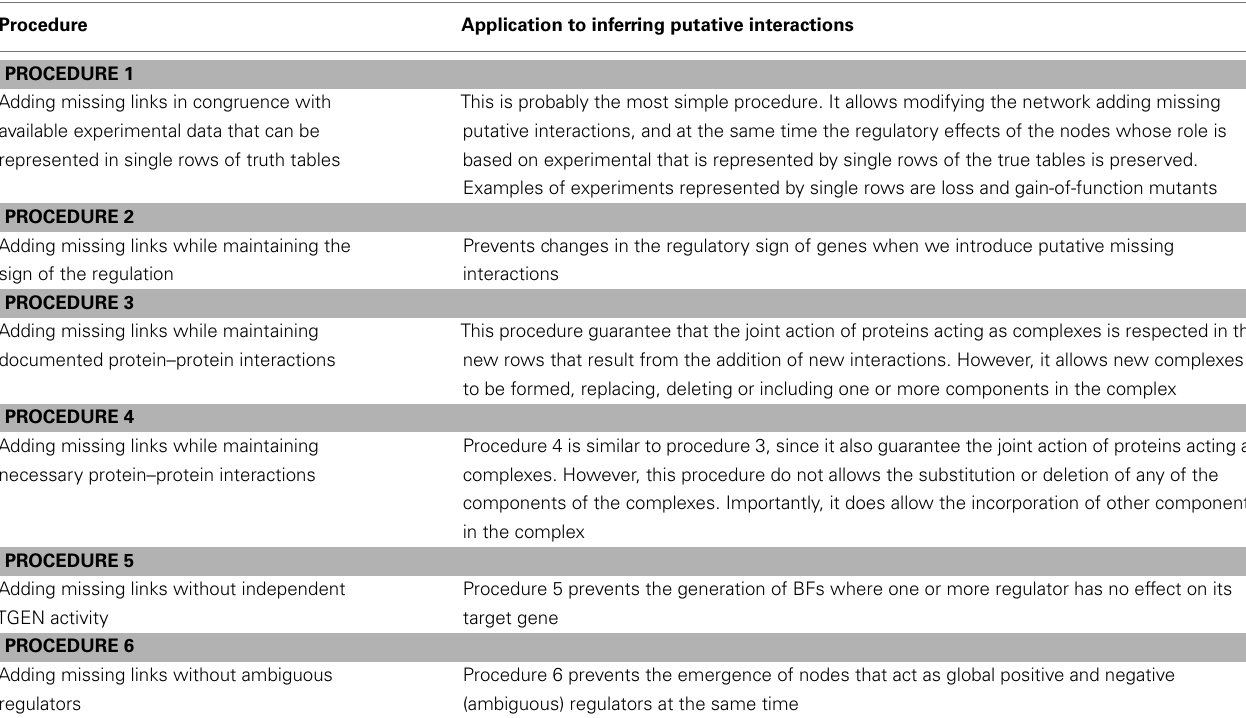
Table 2 | Summary of the procedures proposed to infer putative missing interactions in data-based network